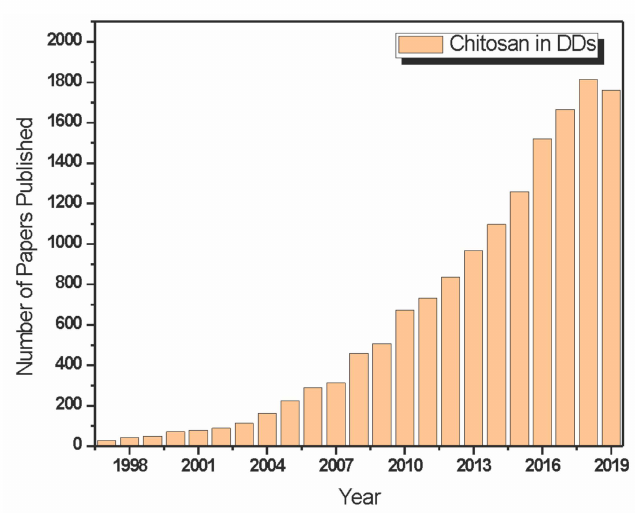
Figure 4. Literature data extracted from the Web of Science Core Collection about papers that address chitosan (CS) uses in drug delivery systems